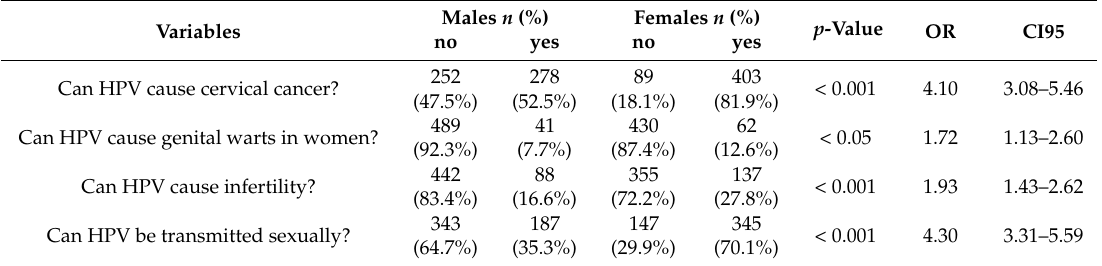
Table 6. Gender-based comparison of knowledge about the etiology and spreading of HPV infection.